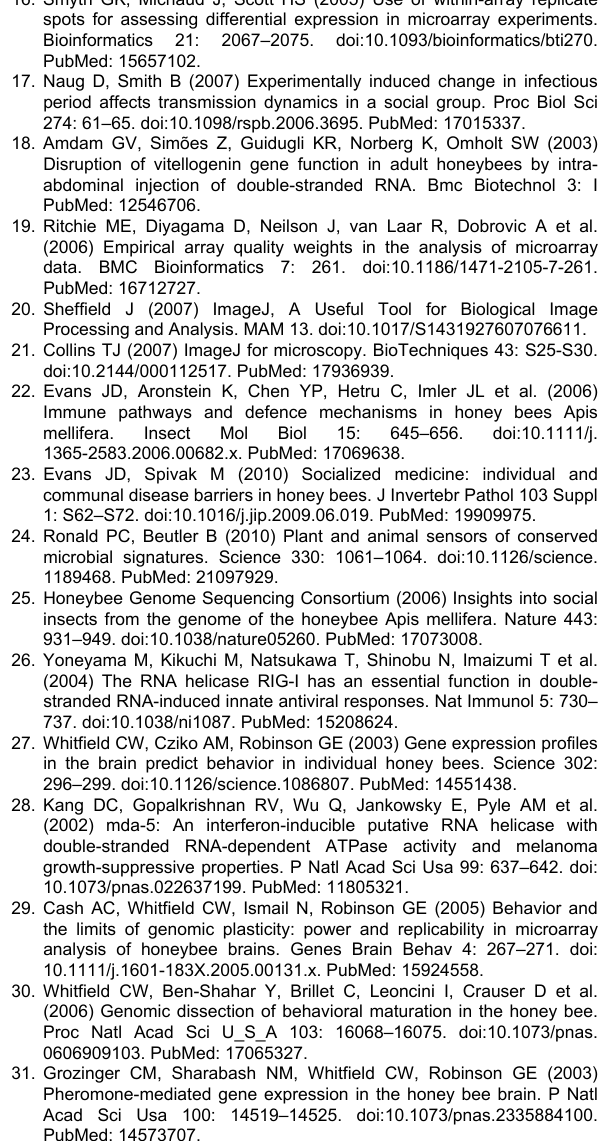
Table S8. PCR and qPCR primer sequences.